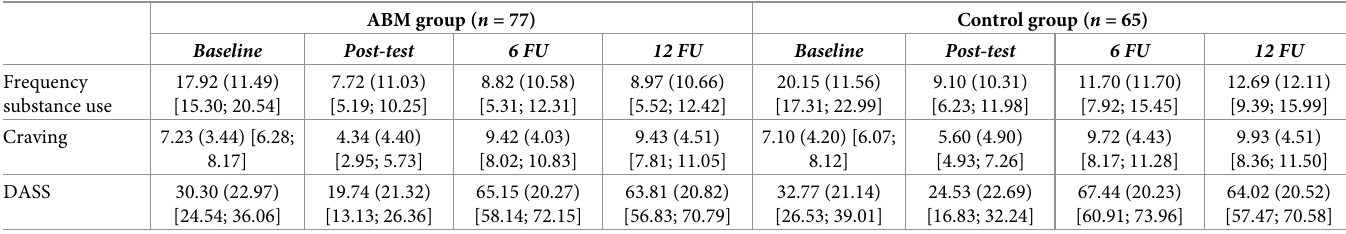
Table 5. Descriptives of the primary outcome variables substance use and craving and the secondary outcome variable per condition and time